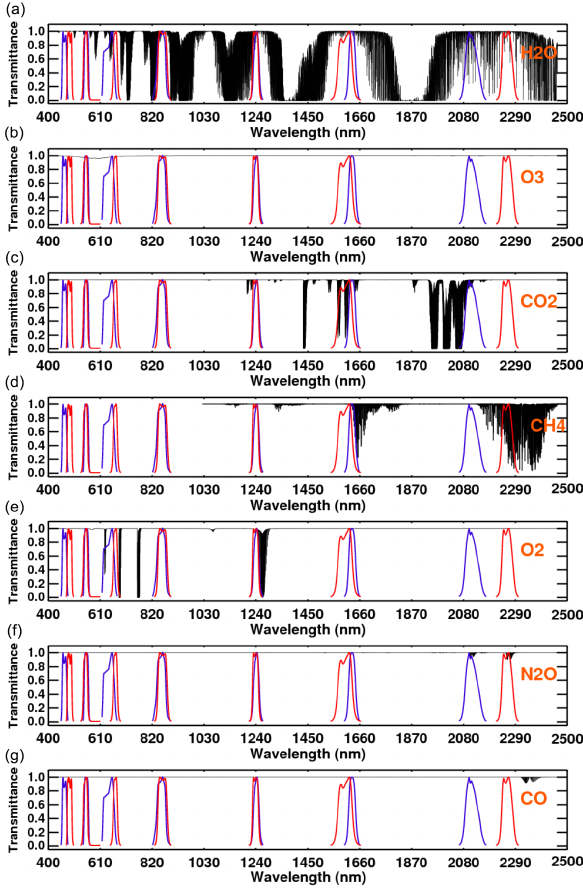
Figure 1. The TOA transmission spectra (black) of the major atmo- spheric gases in the visible and near-infrared part of the electromag- netic spectrum (400–2500nm). The Line-By-Line Radiative Trans- fer Model (LBLRTM) was used to calculate these gas spectra for a nadir-viewing geometry and the US 1976 Standard Atmosphere. The spectral response functions of MODIS channels B1–B7 (blue curves) and seven VIIRS channels (red curves) are overlaid to visu- alize their position in the atmospheric “window” regions where gas absorption effect is